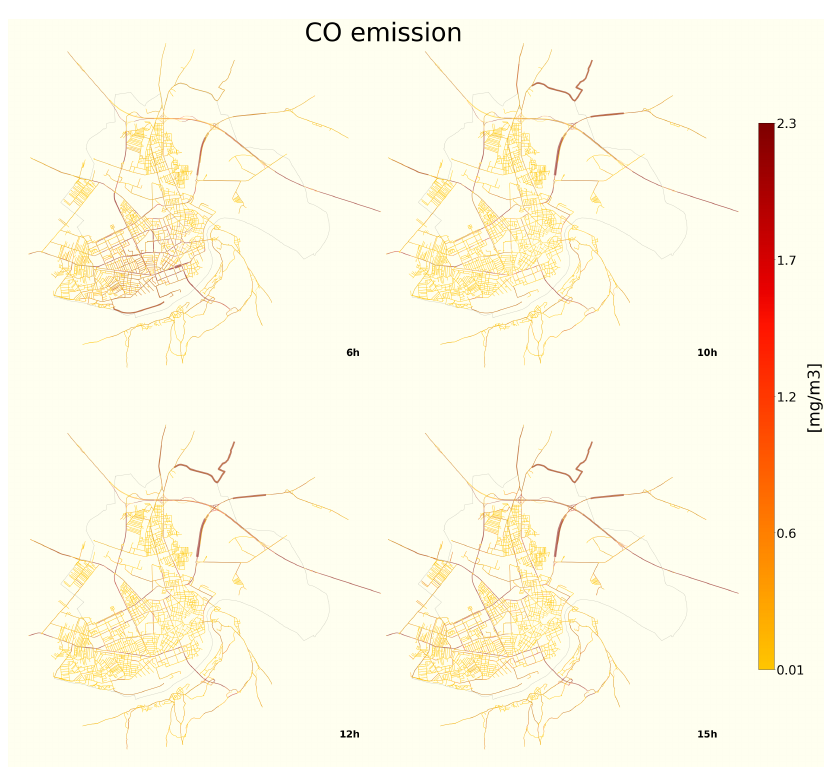
Figure 9. CO emission intensity at different